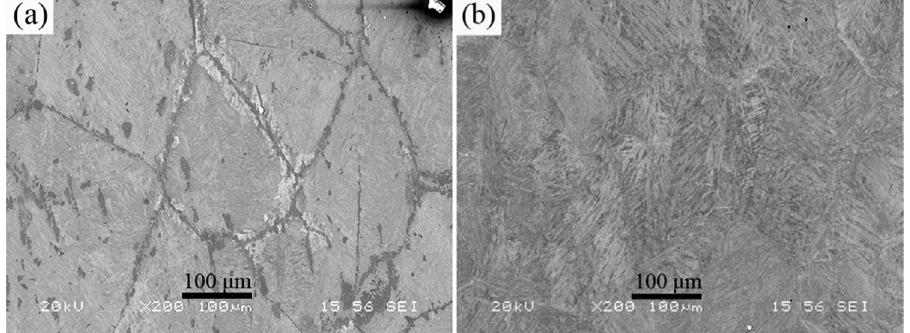
Figure 15: Microstructures near fracture surface at 700°C with a strain rate of 0.005s − 1 observed by SEM: ( a ) steel 7# - 0% Mo; ( b ) steel 8# - 0.5%